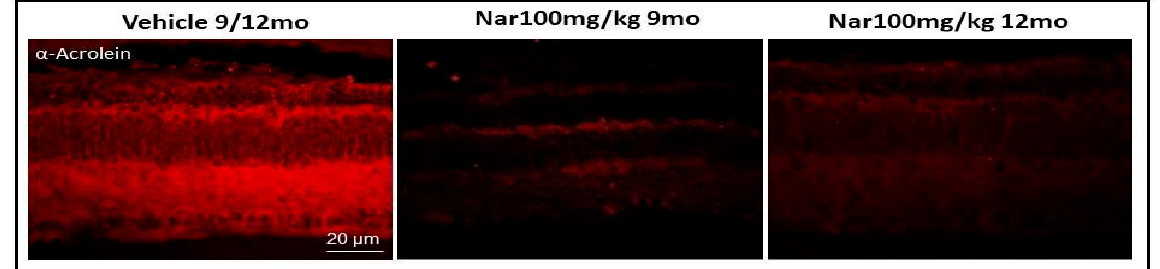
Figure 9. Naringenin reduces lipid peroxidation levels in older C57BL/6J mice. The figure shows the retinal section obtained from animal treated with vehicle alone or with naringenin 100/mg/kg/day respectively for three or six months. Red staining was obtained with the antibody anti-acrolein.